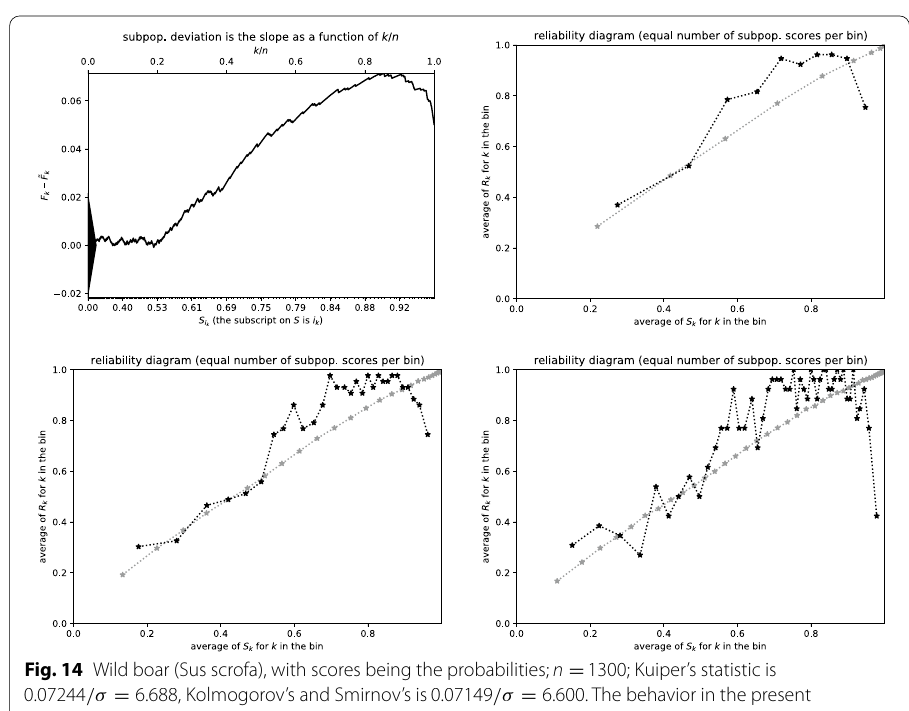
Fig. 14 Wild boar (Sus scrofa), with scores being the probabilities; n = 1300; Kuiper’s statistic is 0.07244 /σ = 6.688 , Kolmogorov’s and Smirnov’s is 0.07149 /σ = 6.600 . The behavior in the present figure at the highest probabilities is similar to that in Fig. 13—the reliability diagrams with only 10 or 30 bins each underplay the very high deviation for the highest probabilities, smoothing away big deviation without warning. As in Fig. 13, the scalar summary statistics detect statistically significant deviation, while both are blind to the significant deviation for the highest scores that the plot of cumulative differences highlights; the steep drop at the highest scores in the cumulative plot has essentially no impact on the Kolmogorov-Smirnov or Kuiper metrics,